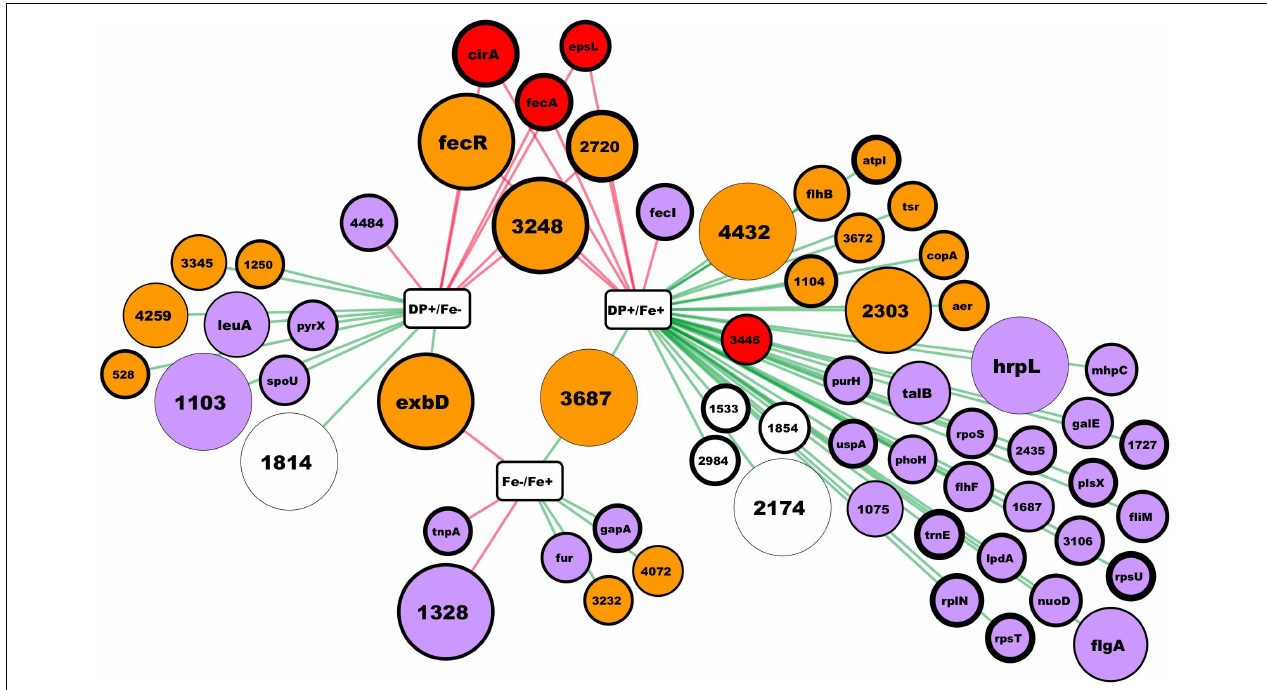
FIGURE 1 | RNA-seq results summary. In this network, rectangular nodes correspond to the experimental conditions compared, circular nodes correspond to genes (named by gene symbol or by the # in the Hsero_# locus tag) differentially expressed according to our criteria. Red edges connect a conditions comparison with the up-regulated genes, while green edges connect the down-regulated ones. Nodes colors represent putative protein cellular localization: red outer membrane, orange inner membrane, light violet cytoplasmic, blank not enough information. Nodes diameter correlate with the absolute fold change from the comparison connected by an edge. In the case of nodes connected to two comparisons, fold change is the one from the comparison with the higher difference in iron availability between conditions. Nodes border thickness correspond to the Log 2 of the mean RPKM of the condition in the comparisons nodes (rectangles) with the lower iron